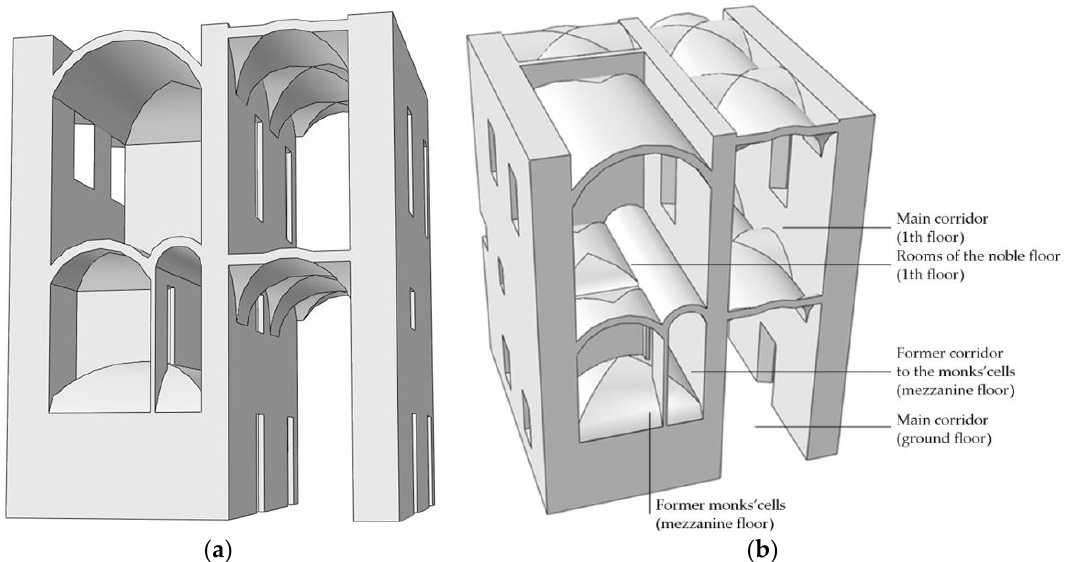
Figure 13. Views of the 3D geometry of Vanvitelli’s Modulus: ( a ) North–South direction; ( b ) Upper view.